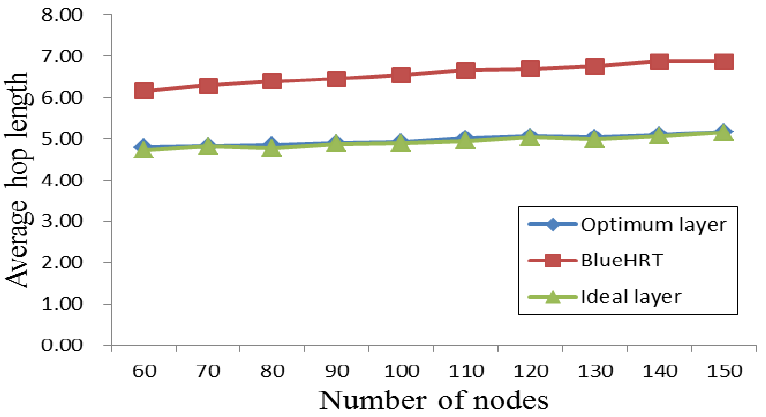
Figure 9. Average path length in a scatternet.